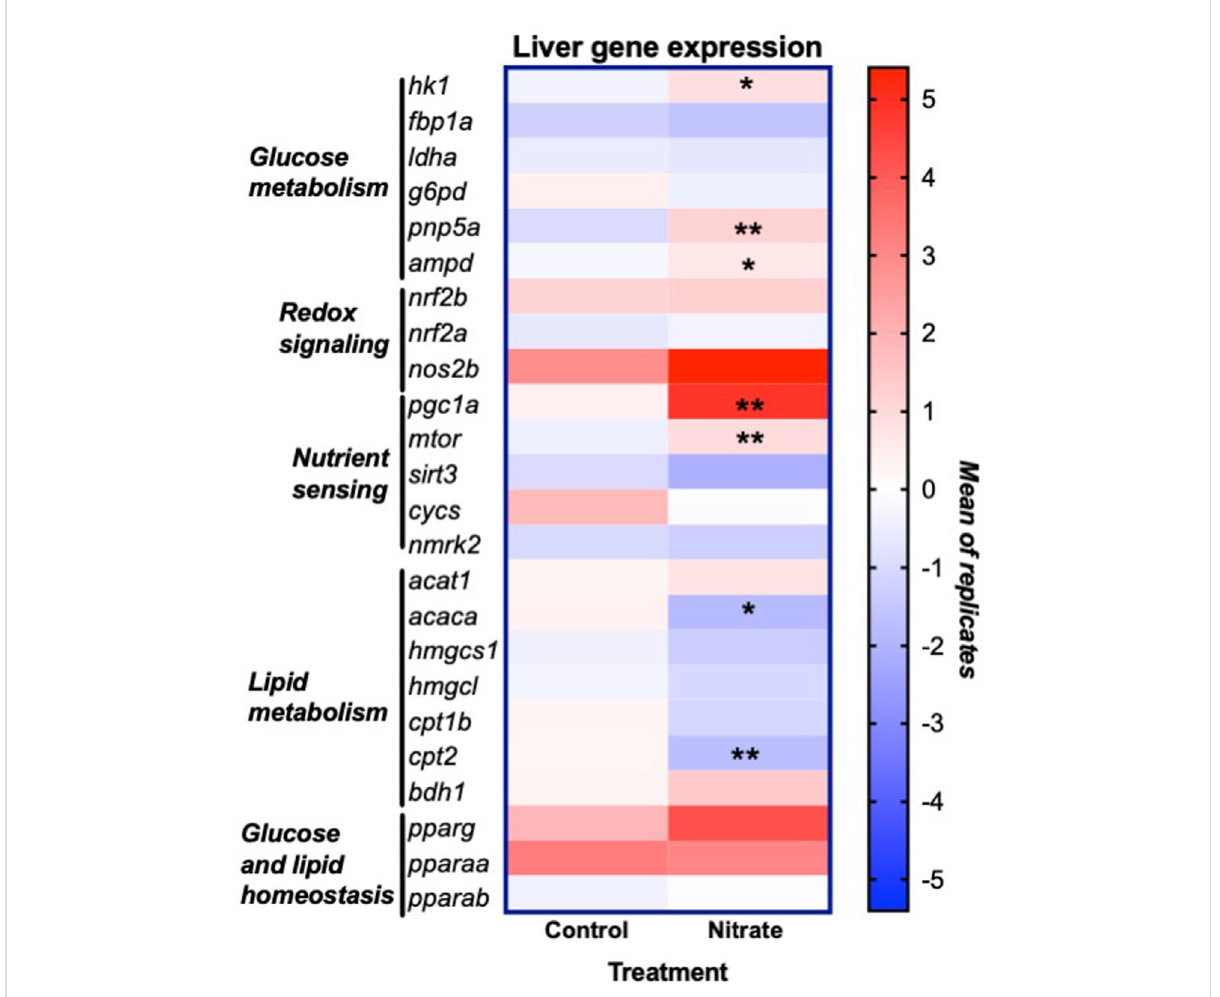
FIGURE 5 Expression ofgenesinvolvedinliverenergymetabolism andredoxsignalingresultingfromnitratetreatment.The heatmapwasgeneratedwith Prism and color mapping represents the mean of each treatment group. Negative and positive values indicate downregulation and upregulation compared to control values, respectively. Asterisks indicate signi fi cance; *, p < 0.01; **, p < 0.001. (n = 6 – 8/group). hk1 , hexokinase 1; fbp1a , fructose-1,6-bisphophatase a; ldha , lactate dehydrogenase a; g6pd , glucose-6-phosphate dehydrogenase ; pnp5a , purine nucleoside phosphorylase5a; ampd1 , adenosine monophosphate 1; nrf2a ,nuclear factorerythroid 2-related factor2a; nrf2b , nuclearfactorerythroid2-related factor 2 b; nos2b , nitric oxide synthase 2b; pgc1a , peroxisome proliferator-activated receptor gamma coactivator 1-alpha; mtor , mammalian target of rapamycin; sirt3 , sirtuin 3; cycs , cytochrome c oxidase; nmrk2 , nicotinamide riboside kinase 2; acat1 , acetyl-CoA acetyltransferase 1; acaca